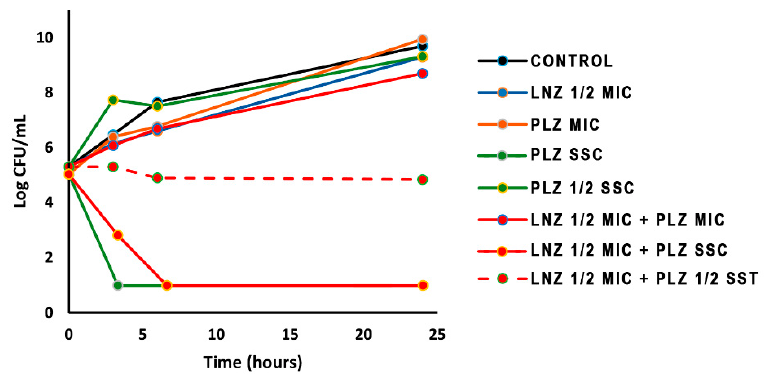
Figure 1. Time kill curves of LNZ (1/2 MIC) plus different concentrations of PLZ against S. aureus HCSC-Sa14. LNZ: linezolid; PLZ: plazomicin; MIC: minimum inhibitory concentration; SSC: steady state concentration; CONTROL: growth in Mueller–Hinton broth without antibiotics.